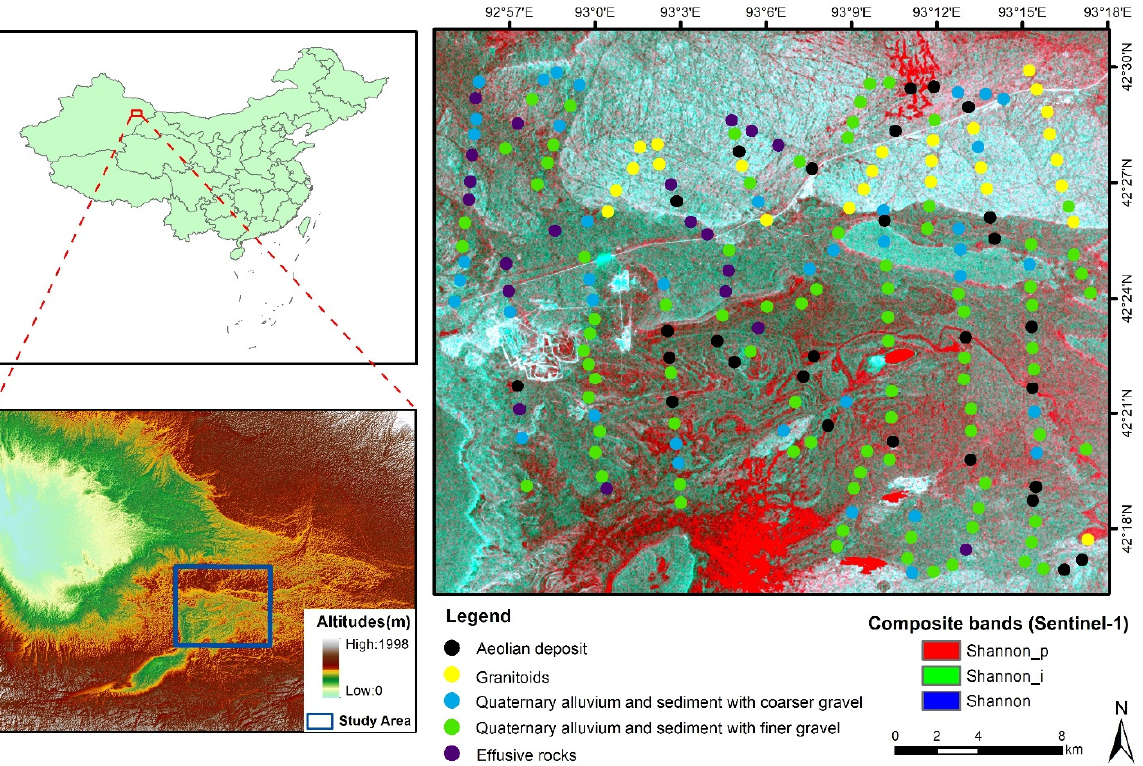
Figure 1. Distribution of samples in the study area. The background image is Shannon entropy extracted from Sentinel-1. Elevation data are derived from the shuttle radar topography mission (SRTM).